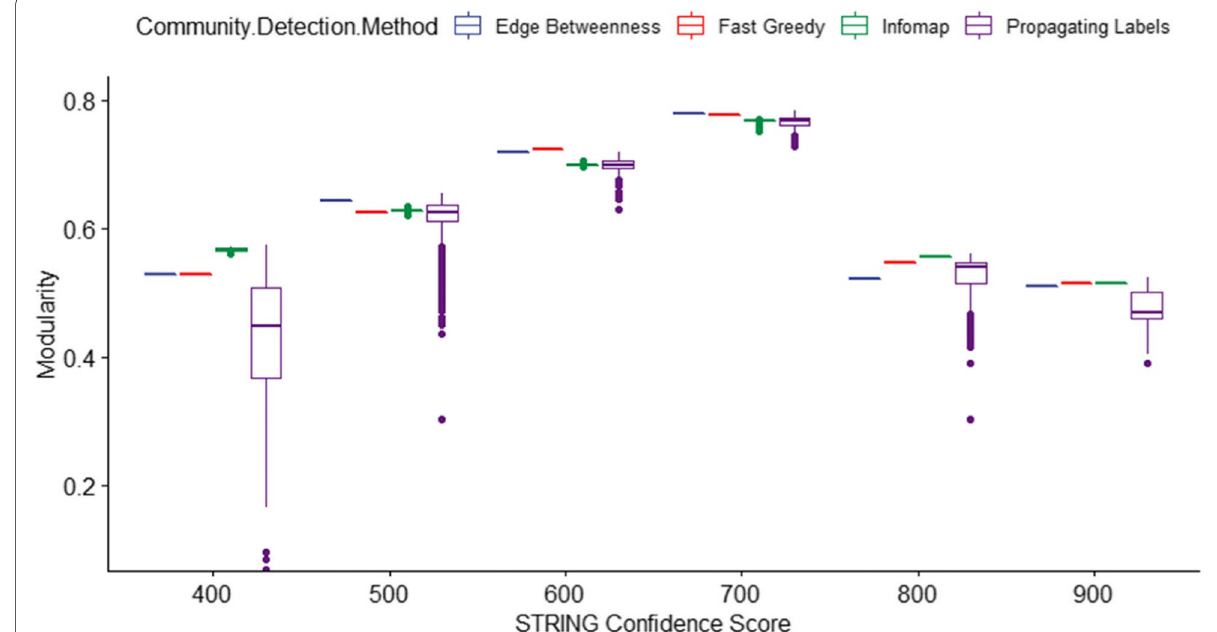
Fig. 3 Comparison of the modularity of the four community structure detection algorithms: edge betweenness, fast greedy, infomap, and propagating